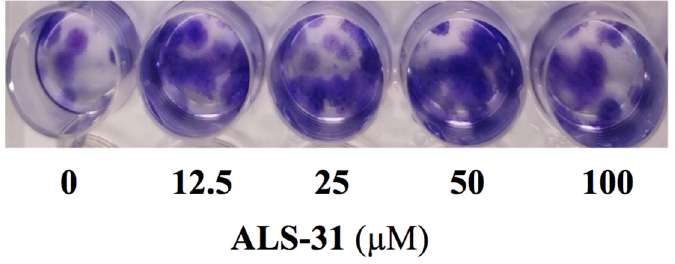
Figure 6. Effect of ALS-31 on the colony formation of fibroblast cell line BJ-5ta. Cells were treated with vehicle alone or the indicated concentration of ALS-31 . After 10 days treatment, plates were photographed and images of representative experiments are shown. Other details are as indicated in the Materials and Methods section.